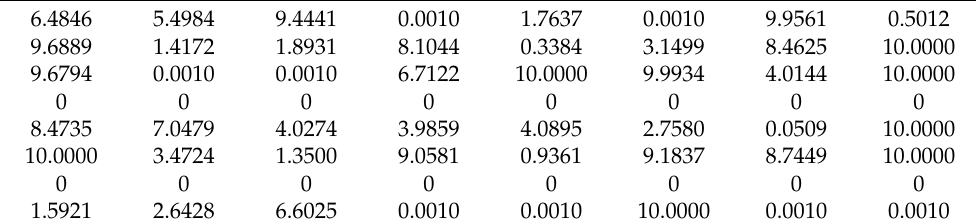
Table 5. Optimized weights for Type 1 failure for the PSO method.